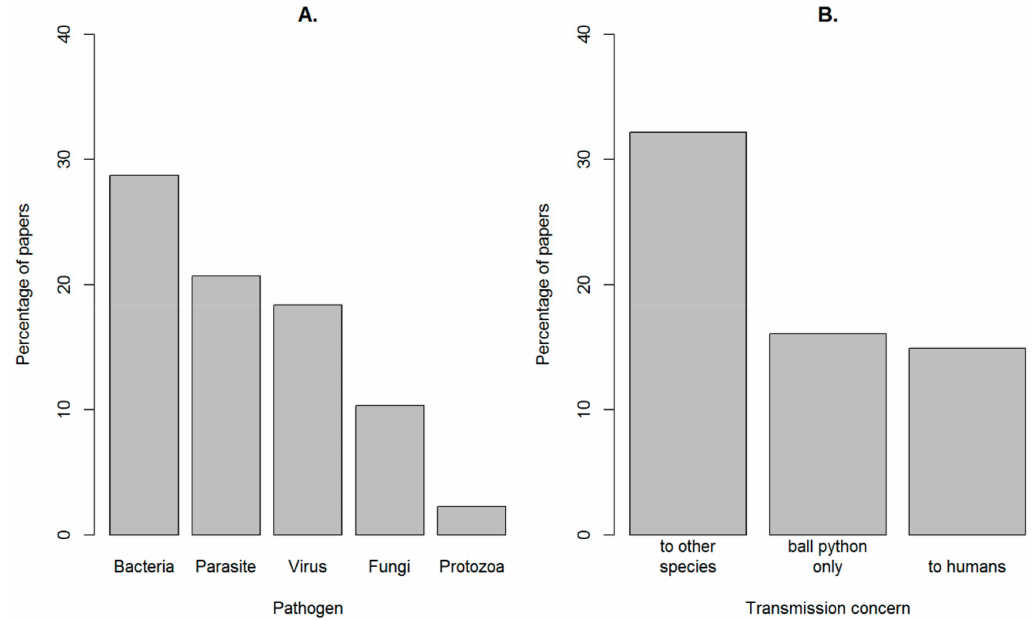
Figure 3. Percentage of papers that mentioned di ff erent pathogen types ( A ) and the di ff erent transmission concerns ( B ). A full list of the specific pathogen species (or taxa) is shown in Appendix